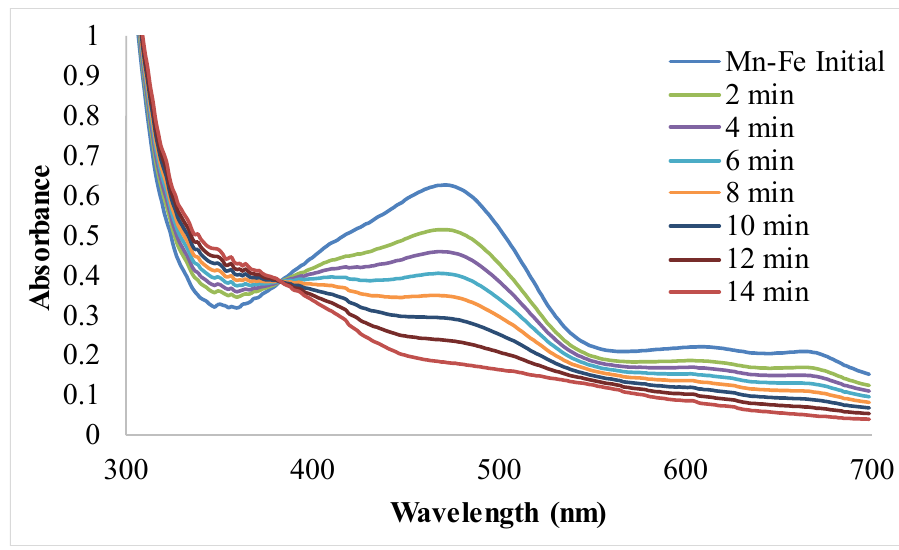
Figure 9. UV-visible spectra for photocatalytic degradation of MO using Fe-Mn NPs.